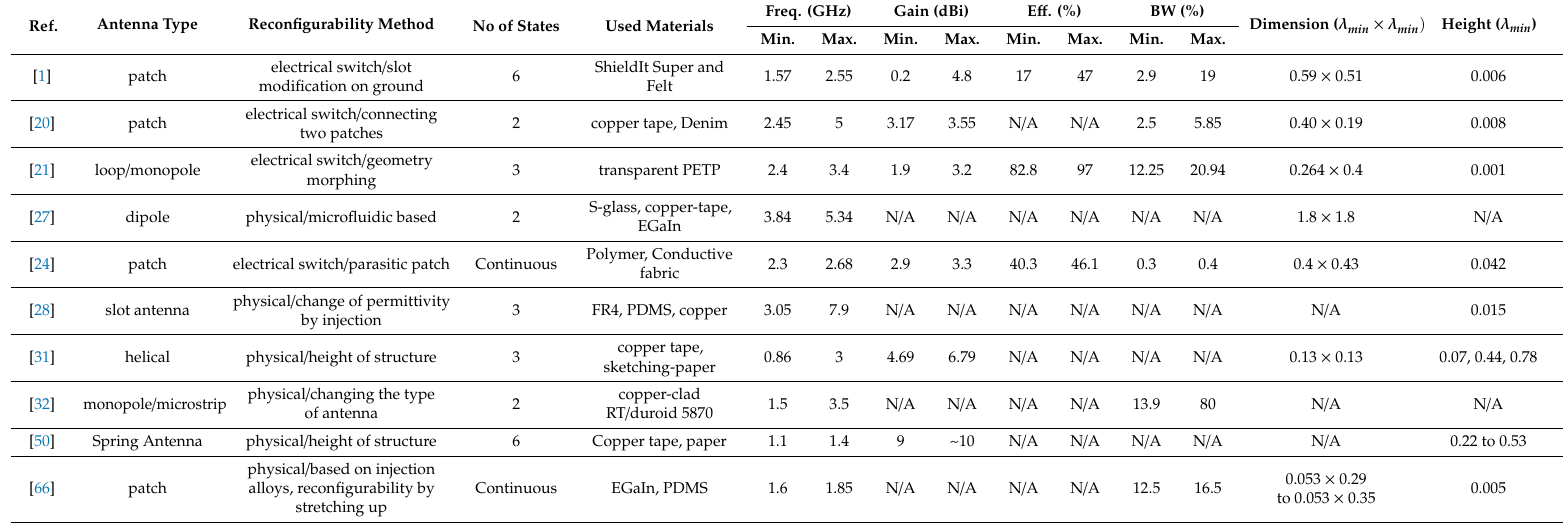
Table 1. Comparison of methods and materials used in di ff erent kinds of flexible frequency-reconfigurable antennas, along with corresponding performance.